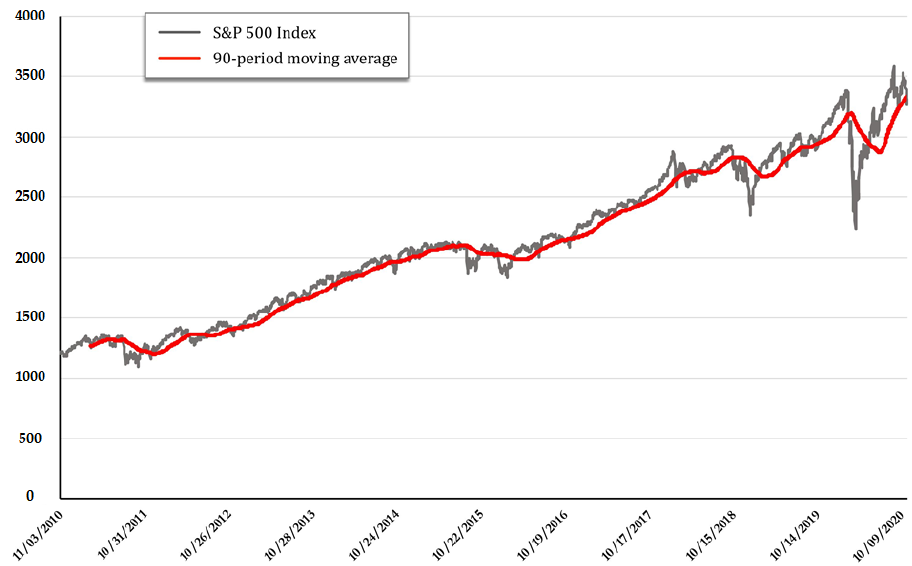
Figure 6. 90-Day smoothed change in S&P Index 2010–2020 (NASDQ 2020).